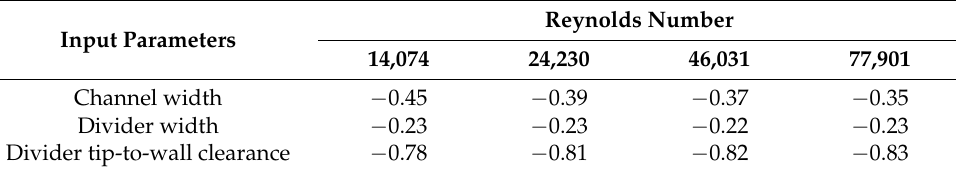
Table 4. Summary of the correlation coefficients.